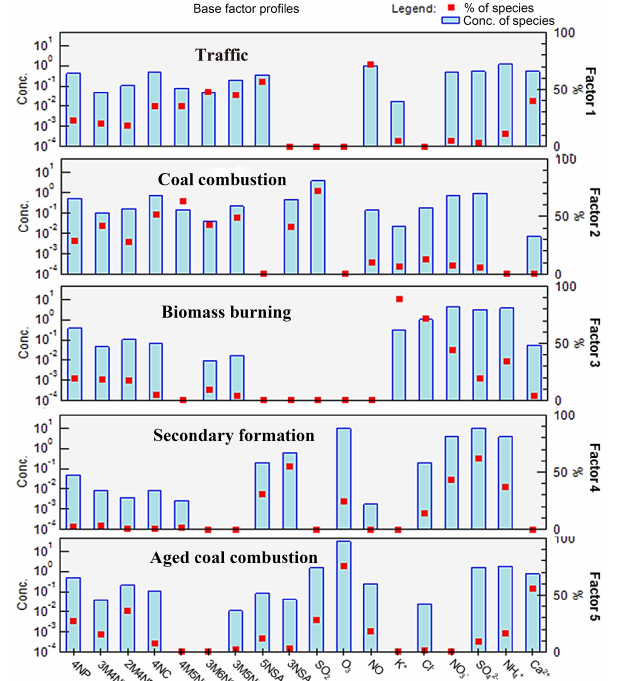
Figure 3. Source profiles of nitrated phenols and related air pollu- tants obtained from PMF